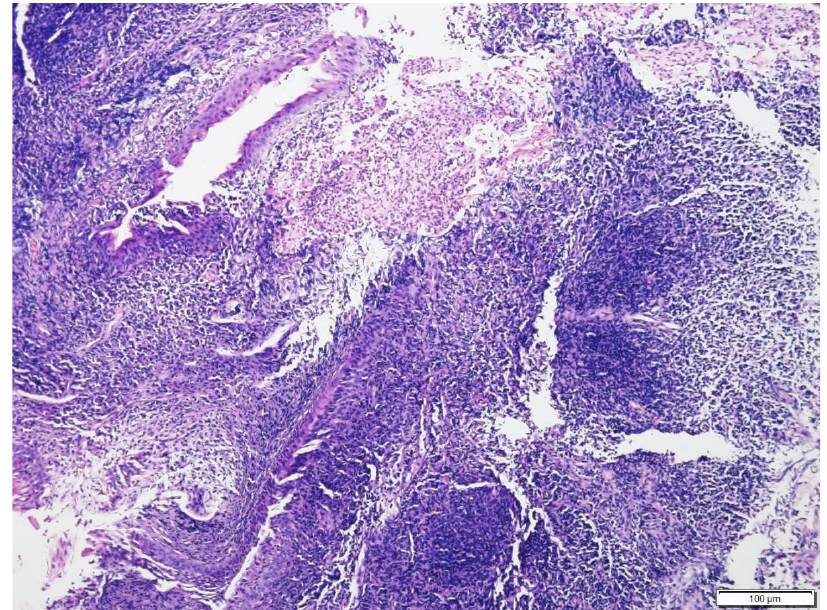
Figure 4. Histologic findings of nasal biopsy of Case N.2. The submucosa is expanded by a dense infiltrate of mixed small and large lymphocytes and plasma cells, and scattered with areas of necrosis. H&E stain (100× magnification).